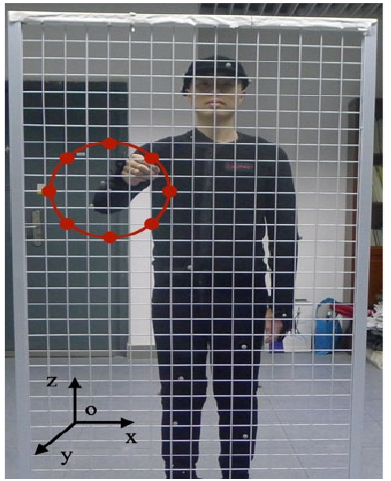
Figure 9. The experiments of drawing a circle.